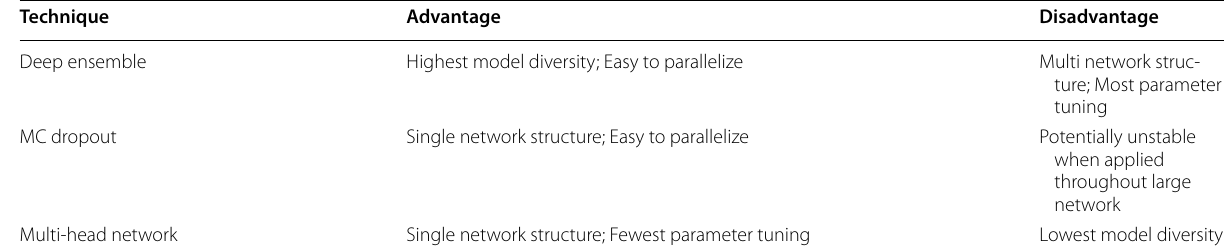
Table 3 Comparison of probabilistic network techniques Technique